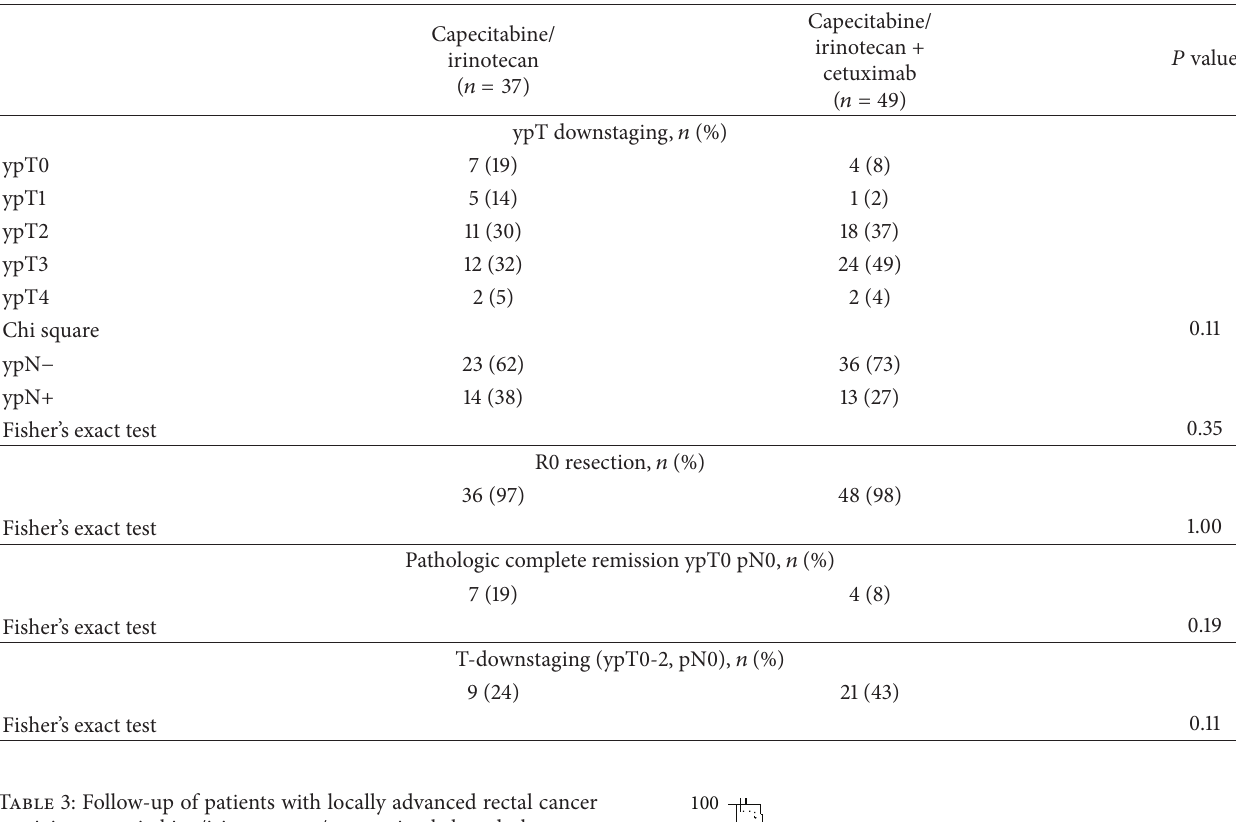
Table 2: Pathohistological results of patients with locally advanced rectal cancer receiving capecitabine/irinotecan +/ − cetuximab based chemoradiotherapy as preoperative treatment.